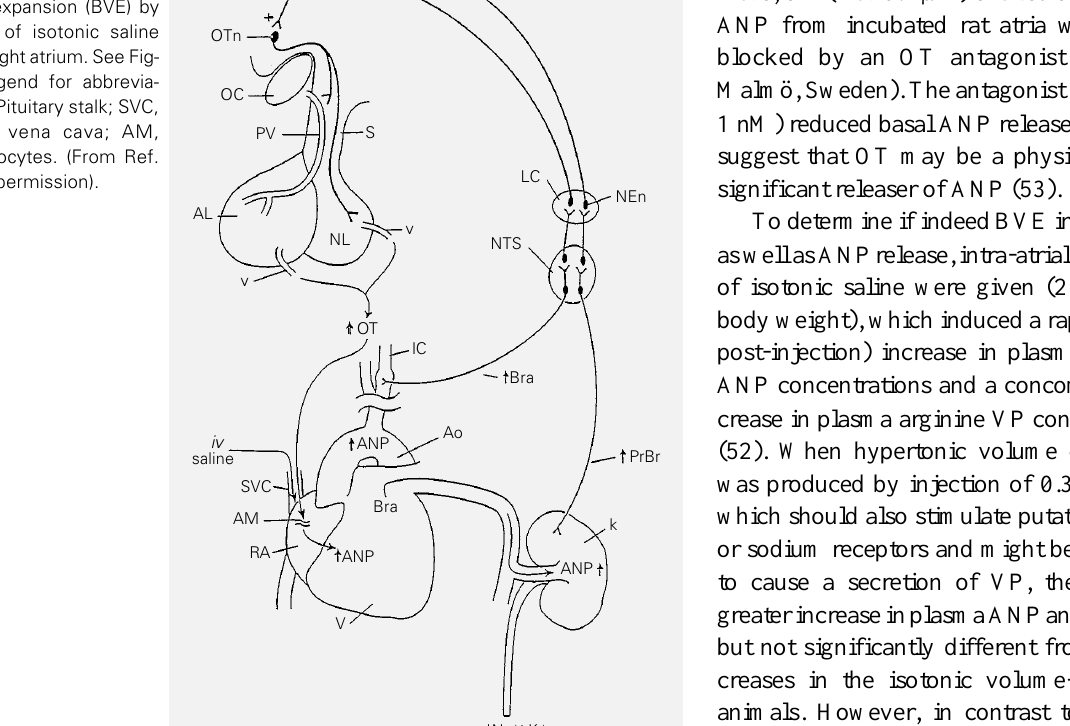
Figure 2 - Schematic dia- gram of the mechanism of natriuresis following blood volume expansion (BVE) by injection of isotonic saline into the right atrium. See Fig- ure 1 legend for abbrevia- tions. S, Pituitary stalk; SVC, superior vena cava; AM, atrial myocytes. (From Ref. 52, with